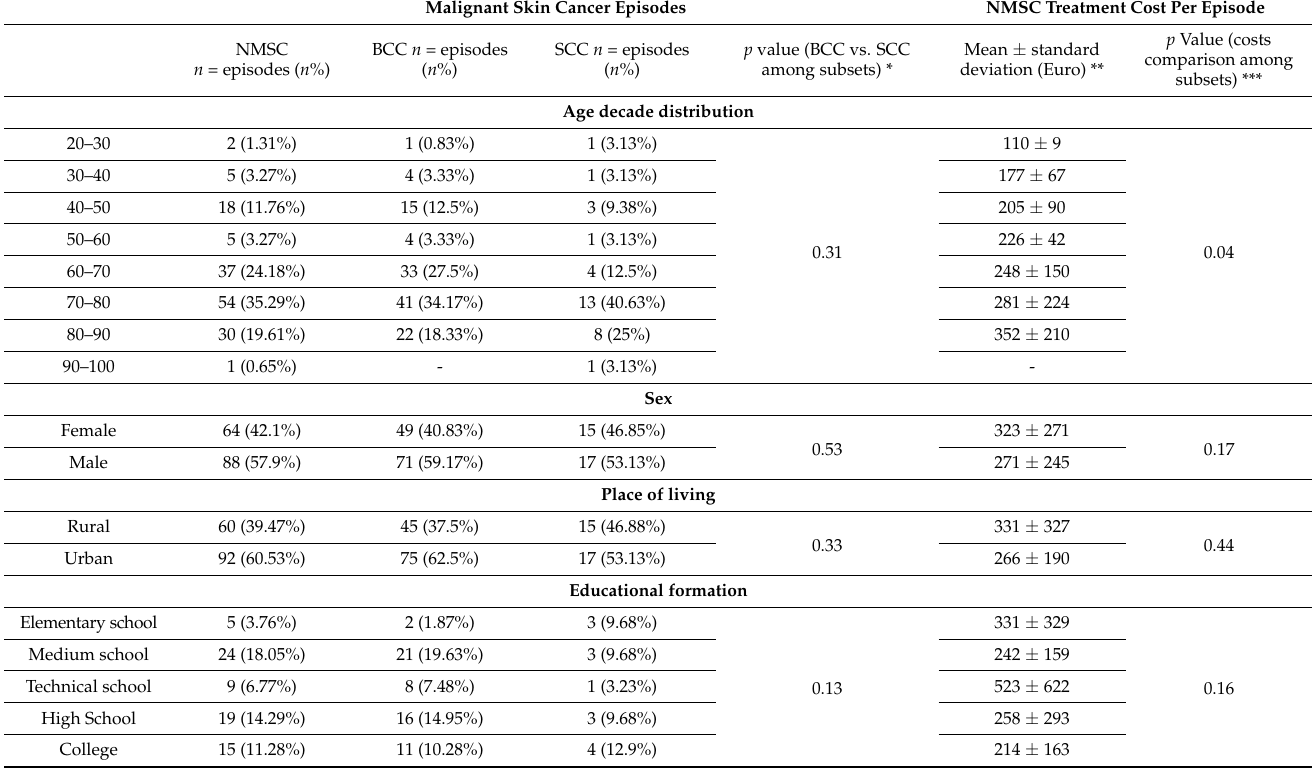
Table 1. Non-melanoma skin cancer epidemiology and treatment